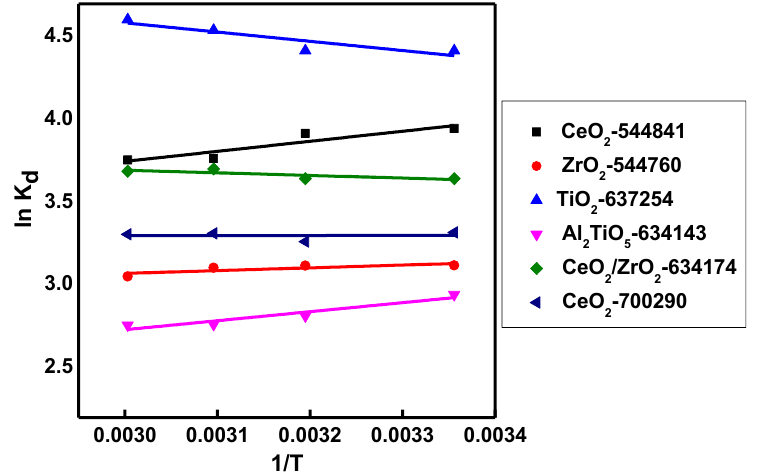
Figure 4. Van’t Hoff plot for the sorption of CA - 99 Mo on different metal oxides